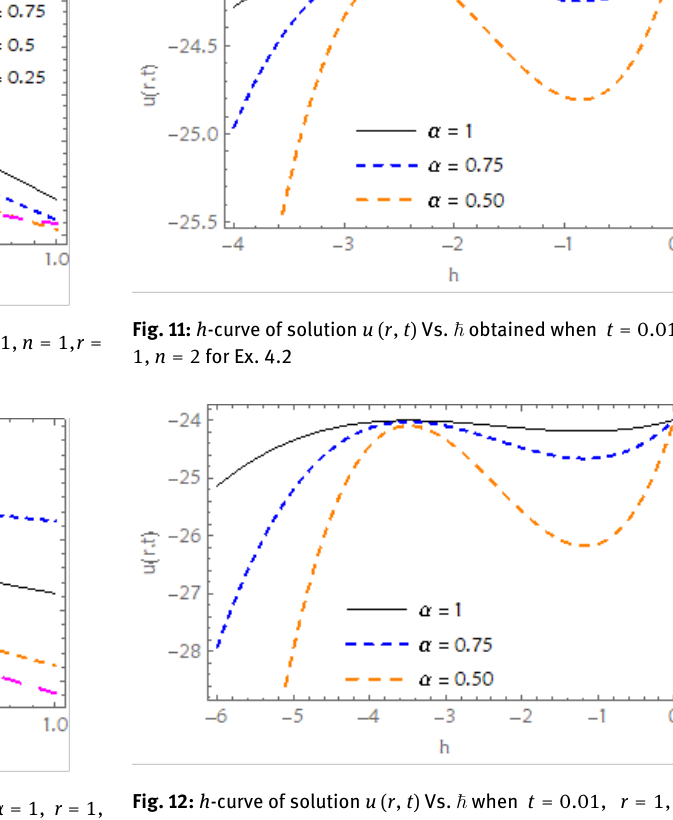
Fig. 9: Plot of solution u ( r , t ) Vs. t when P = 1, n = 1, α = 1, r = 1, for Ex. 4.2.